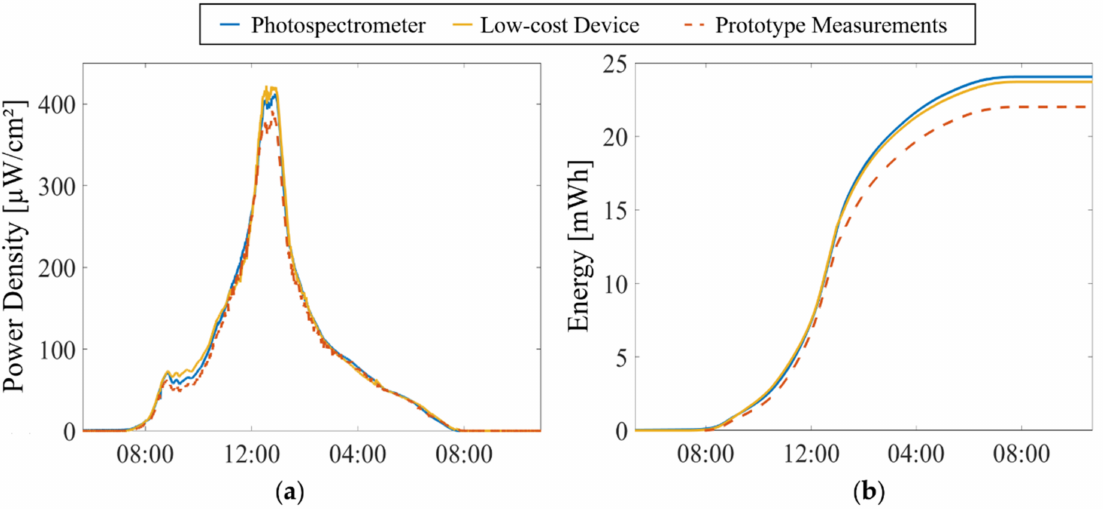
Figure 12. Result of the reconstruction method, after implementing a more accurate correction of the measured values by the low-cost light intensity system ( a ) Power density and ( b ) Energy harvested according to model calculations (solid lines) or prototype measurements (dashed